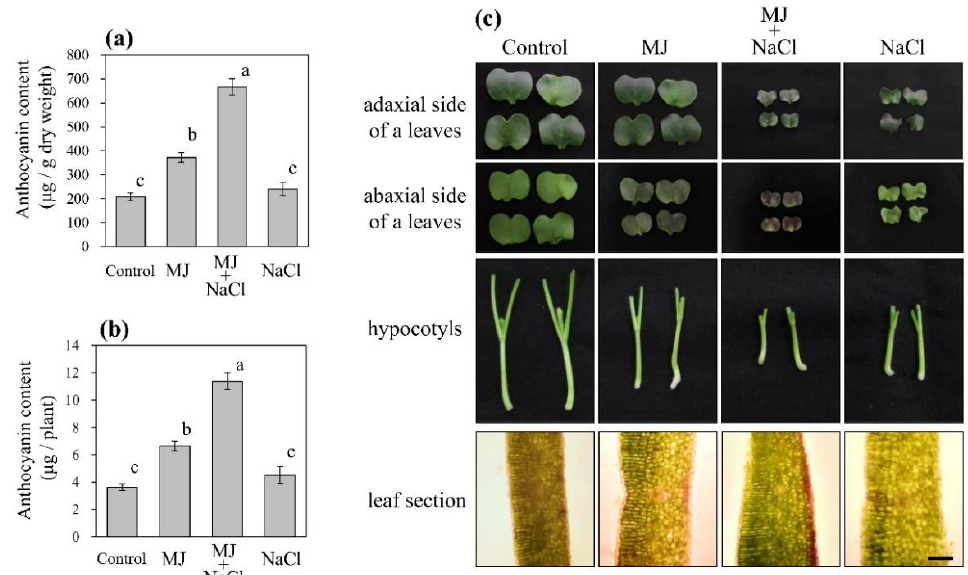
Figure 1. Simultaneous effect of methyl jasmonate (MJ) and salinity treatments on anthocyanin accumulation in radish sprouts. Anthocyanin contents of per unit dry weight ( a ) and anthocyanin content per plant ( b ) were measured after treatments with water (Control), 0.5 mM MJ (MJ), 200 mM NaCl (NaCl), and co-treatment with 0.5 mM MJ and 200 mM NaCl (MJ + NaCl). ( c ) Morphological observation of anthocyanin distribution. Leaf sections were observed under a microscope. Scale bars, 200 μm. Error bars represent ± SE ( n = 13). Different letters indicate significant differences by Tukey’s multiple comparison test ( P < 0.05).